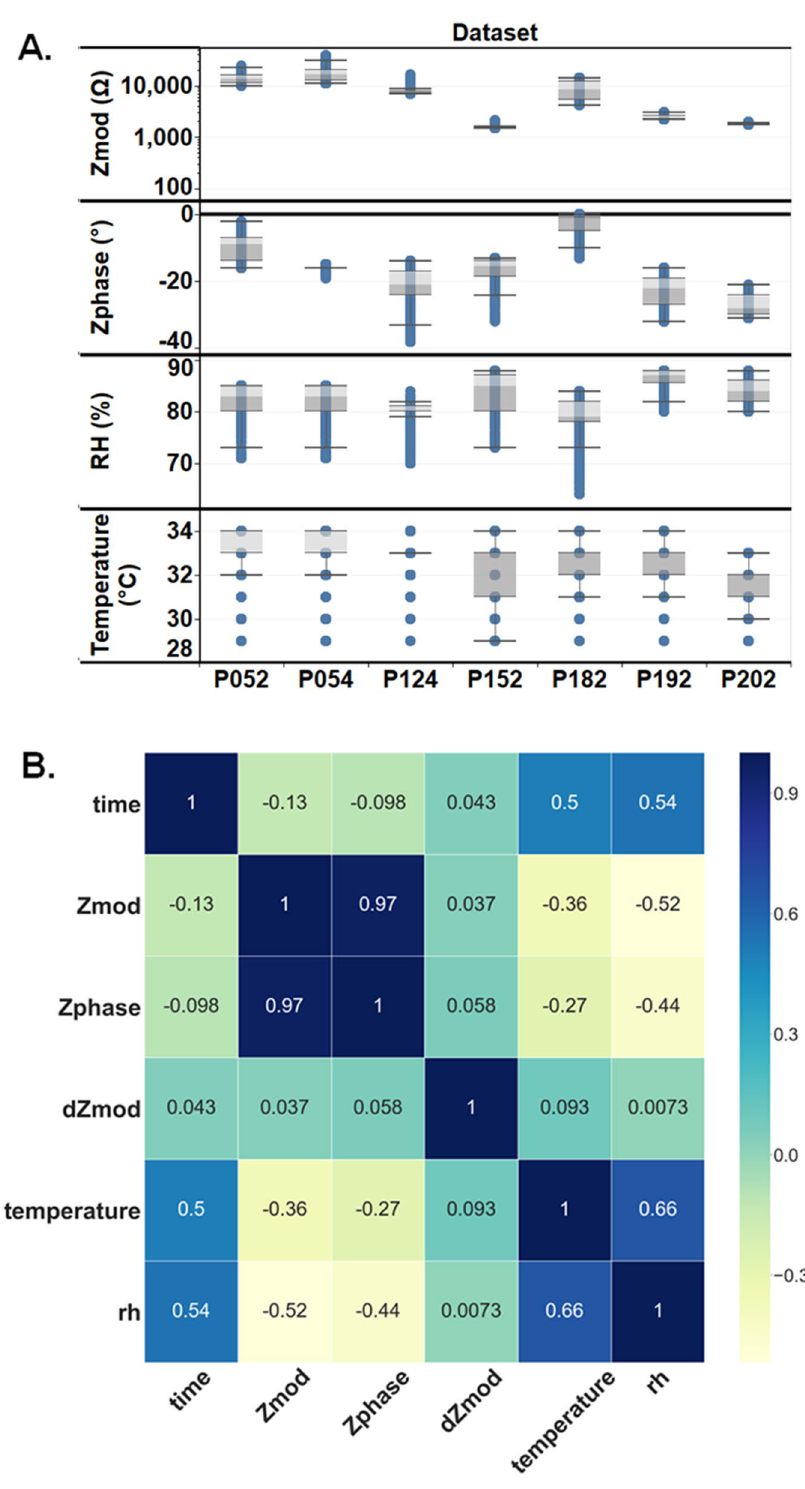
Figure 2. ( A ) Exploratory data analysis of input parameters obtained from the sensor Zmod, Zphase, Temperature and %RH. ( B ) Correlation matrix visualization between the input parameters for the machine learning